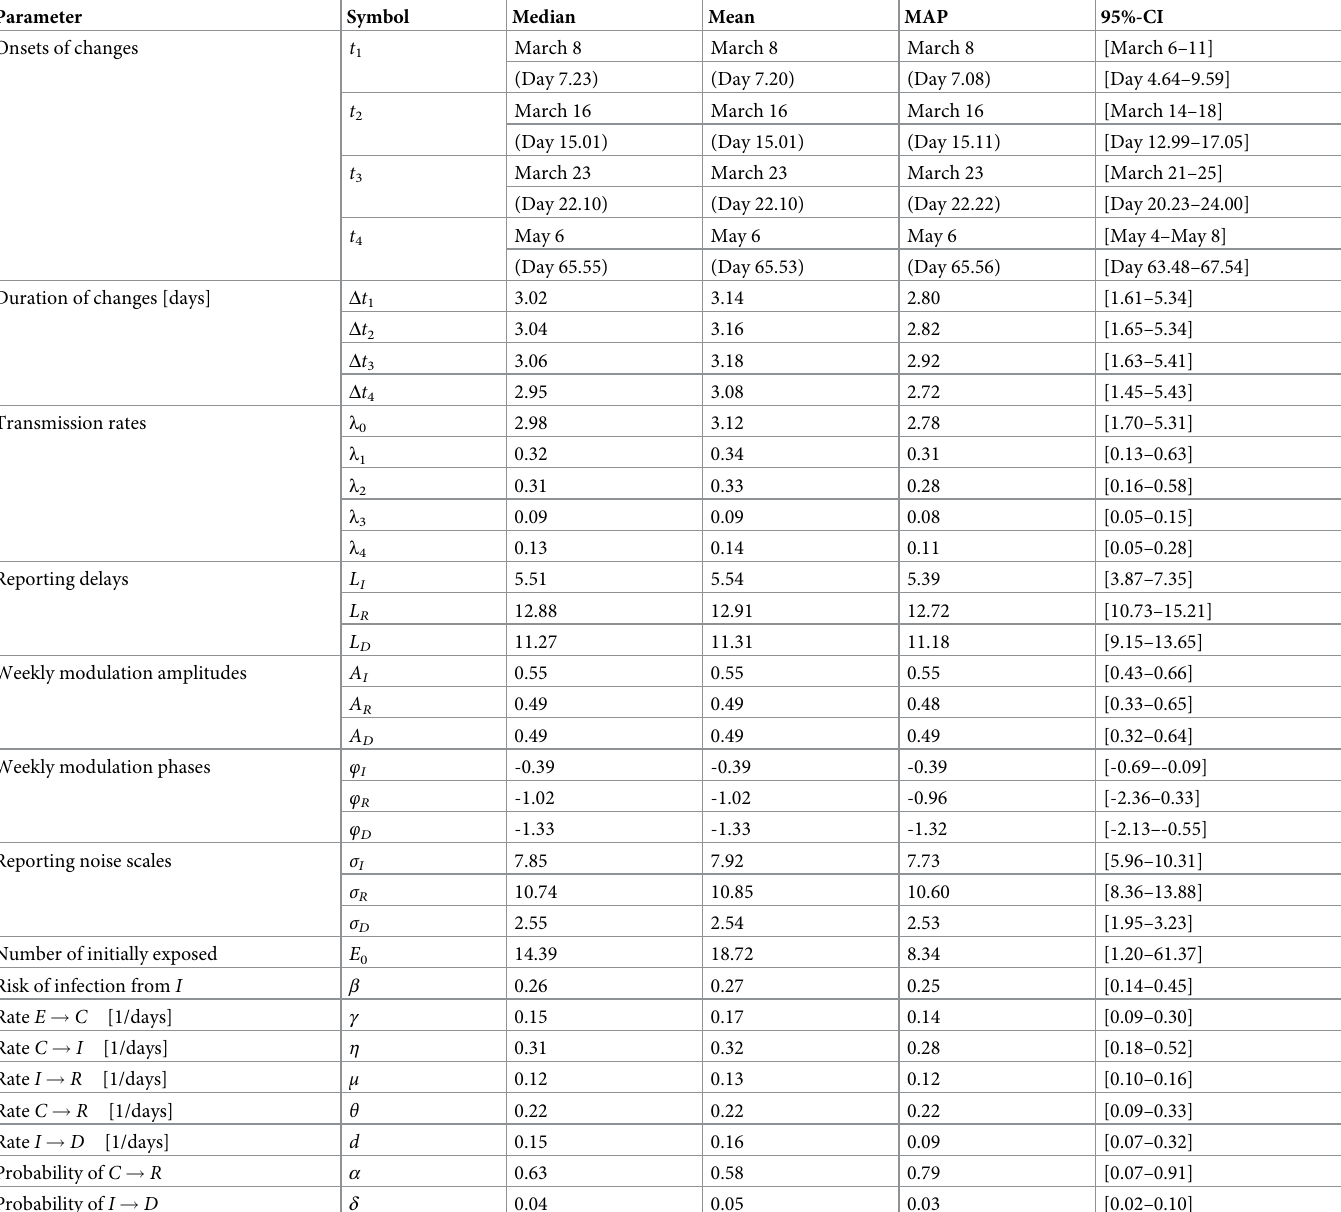
Table 1. Posterior summaries and 95%-CIs for each model parameter inferred from data for entire Germany.